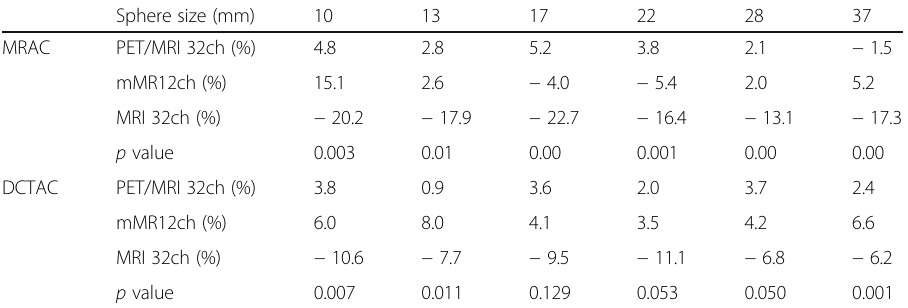
Table 2 CR relative percentage difference between no-array and the anterior (A) part of each array for each sphere size. The CR was estimated for both reconstruction methods (MRAC and off-line DCTAC) Sphere size (mm) MRAC PET/MRI 32ch (%)